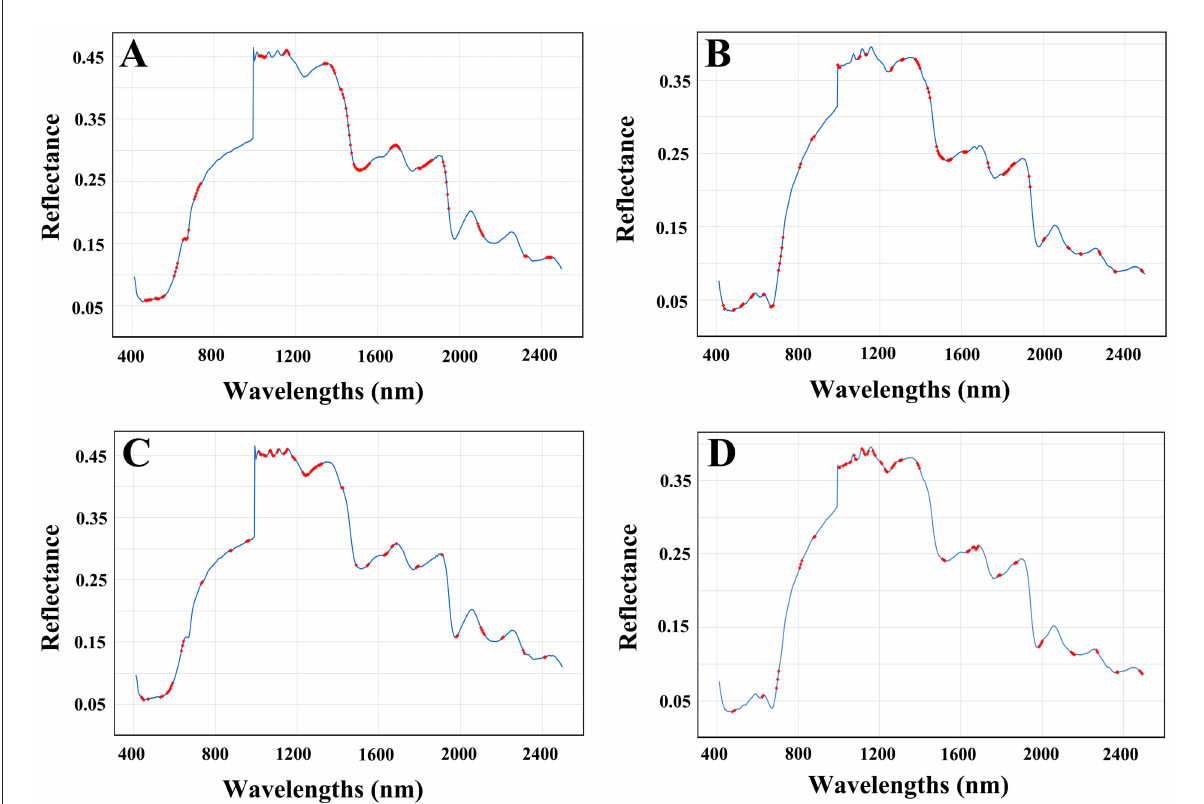
FIGURE3 Selected wavelengths for best prediction in chemical indicators of HJ samples. The selected wavelengths were shown in red dots. (A) Selected wavelengths in AOC prediction of RHJ (MASS-WT-PLSR); (B) selected wavelengths in AOC prediction of GHJ (MASS-WT-RF); (C) selected wavelengths in TALC prediction of RHJ (IVSO-WT-BPNN); (D) selected wavelengths in TALC prediction of GHJ